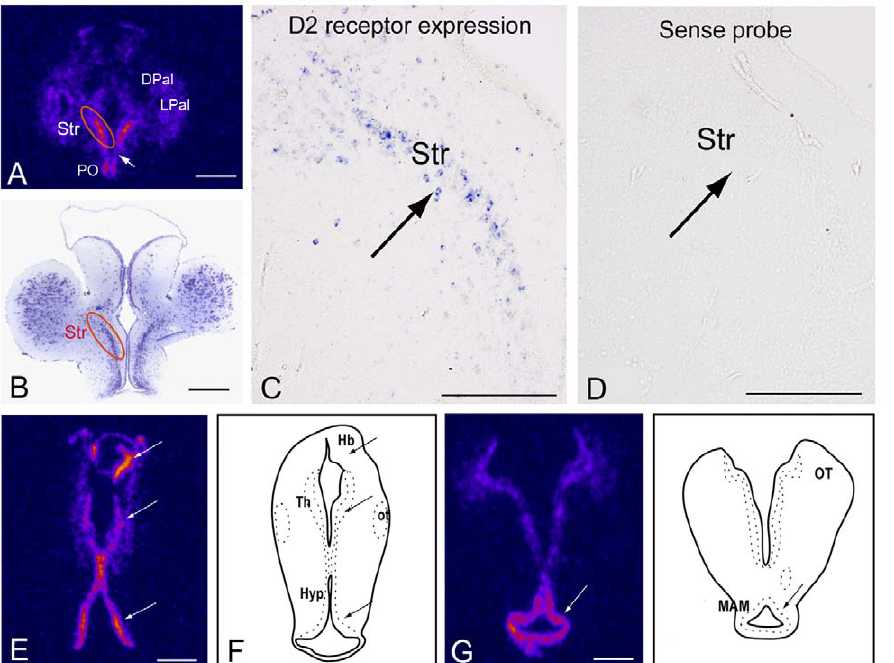
Figure 4. Dopamine D2 receptor expression in the lamprey brain. A. 35 S-UTP-labeled D2 receptor riboprobe shows strong expression in the striatum. D2 receptor expression is also present in the dorsal and lateral pallium although less strong. Note the absence of receptor expression in the magnocellular preoptic nucleus (arrow). B. Nissl stained section from the striatum showing the site of receptor expression in A and C. C. DIG-labeled D2 receptor riboprobe expressed in a subpopulation of striatal neurons. D. DIG-labeled sense riboprobe showing lack of mRNA expression in the section adjacent to the one in Figure 5C. E. 35 S-UTP-labeled D2 receptor riboprobe expression in the habenula, thalamus and hypothalamus. F. Schematic drawing of the lamprey brain indicating the habenula, thalamus and hypothalamus. G. 35 S-UTP-labeled D2 receptor riboprobe shows strong expression in the mammillary area. H. Schematic drawing of the lamprey brain indicating the mammillary area. The pseudocoloring in A, E and G indicates signal intensity from low (black/blue) to high (pink/yellow). Abbreviation: DPal, dorsal pallium; Hb, habenula; Hyp, hypothalamus; LPal, lateral pallium; MAM, mammillary region; ot, optic tract; OT, optic tectum; PO, preoptic nucleus; Str, Striatum; Th, thalamus . Scale bars, A, B, E and G 500 m m; C and D 200 m m.